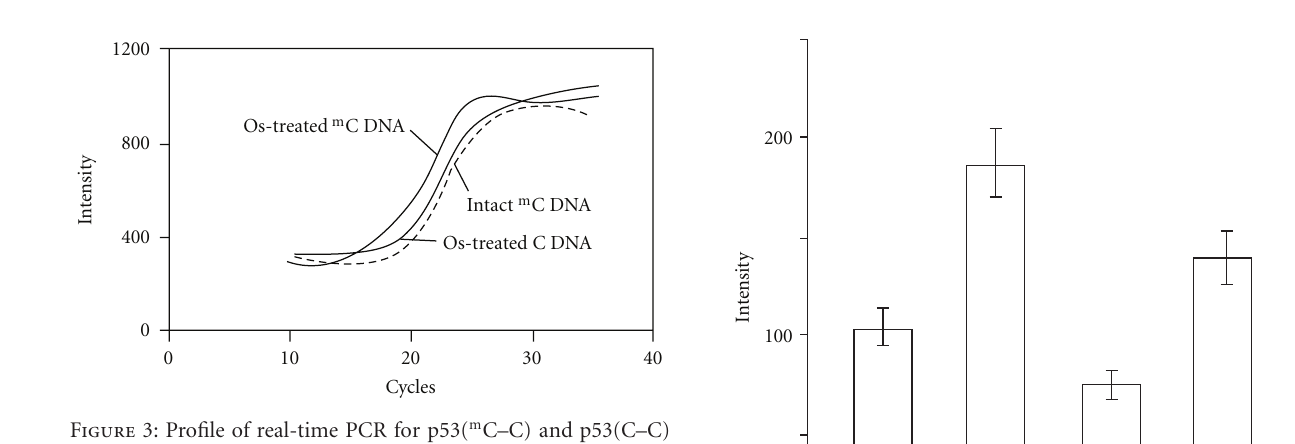
Figure 3: Profile of real-time PCR for p53( m C–C) and p53(C–C) with/without osmium oxidation.